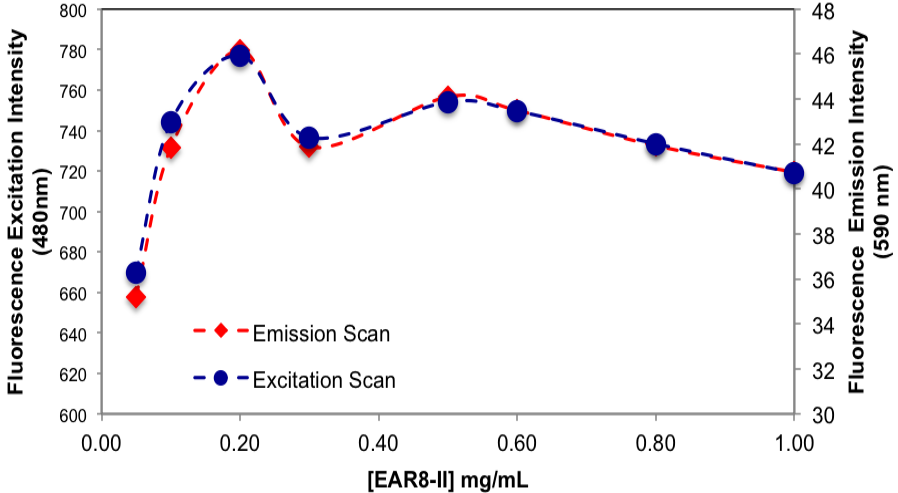
Figure 6. Normalized fluorescence emission and excitation intensities from EAR8-II-THP complexes at fixed [THP] = 0.1 mg/mL and varied